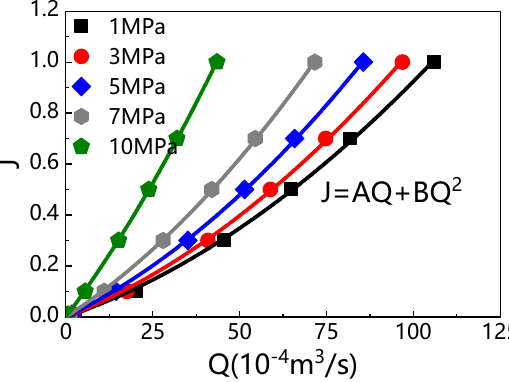
Figure 15. Relationship between J and Q .